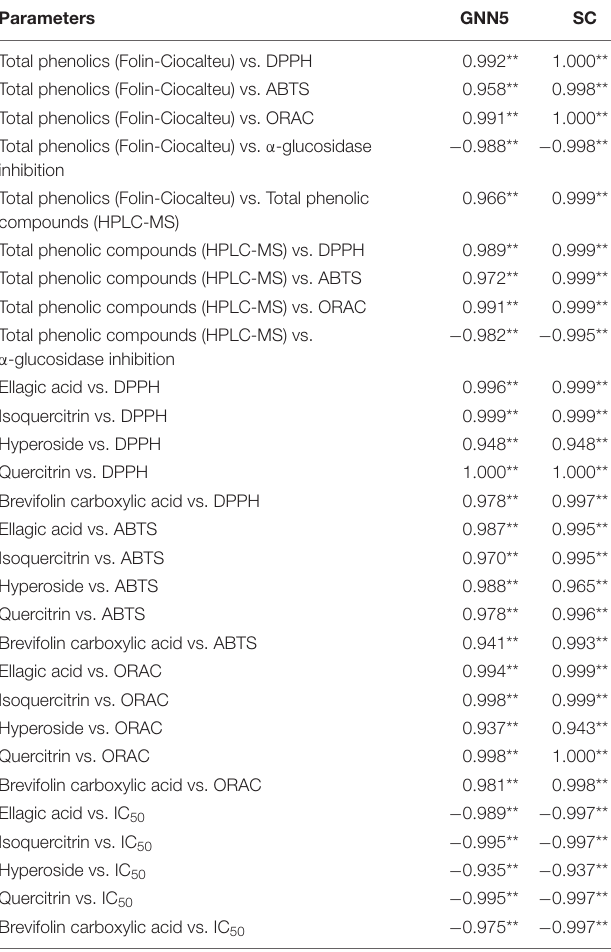
TABLE 3 | Correlation between phenolic compounds and bioactivities. Parameters GNN5 SC Total phenolics (Folin-Ciocalteu) vs. DPPH 0 . 992